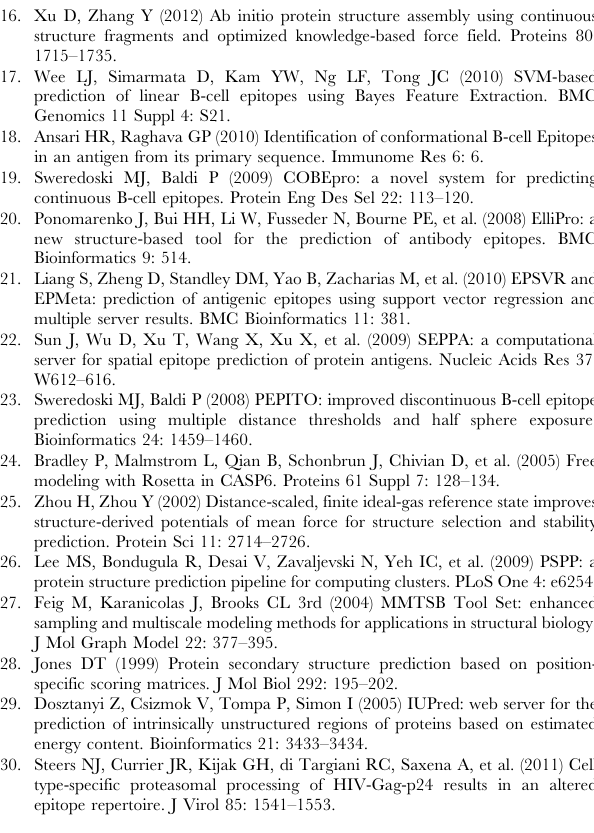
Figure 5. Fine specificity of PfCelTOS-specific T cells. Reactivity was determined by ELISpot analysis measuring Pf CelTOS-specific IFN- c responses. Mouse splenocytes from three strains (inbred BALB/c and C57BL/6 and outbred ICR) were tested against a panel of 43 overlapping peptides (AA=amino acid position within the protein). Putative binding to indicated MHC class I and class II (in bold) alleles was determined by Rankpep analysis. Underlined amino acids designate predicted binding motif for indicated MHC allele. Shading and intensity of shading indicates the magnitude of the T cell response after ex vivo stimulation with the peptides.